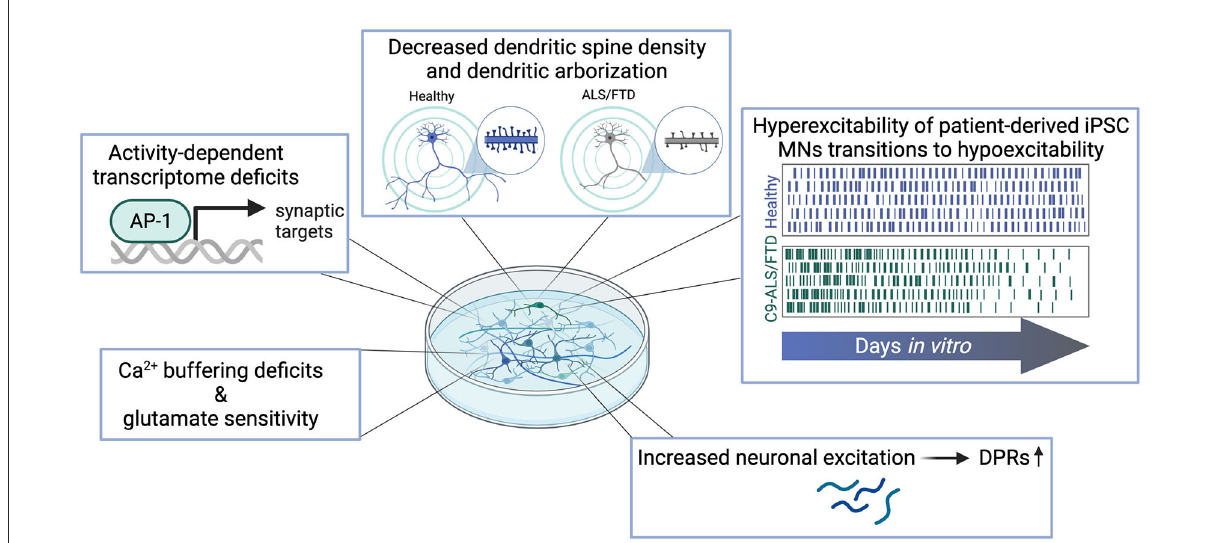
FIGURE2 Synaptic dysfunctions observed in patient-derived in vitro models of C9-ALS/FTD include Ca 2 + -buffering deficits and increased vulnerability to glutamatergic insult, deficits in the activity-dependent transcriptome, decreased complexity of dendritic arborization and loss of dendritic spines, temporal phases of excitability alterations, and increased DPR levels as a result of